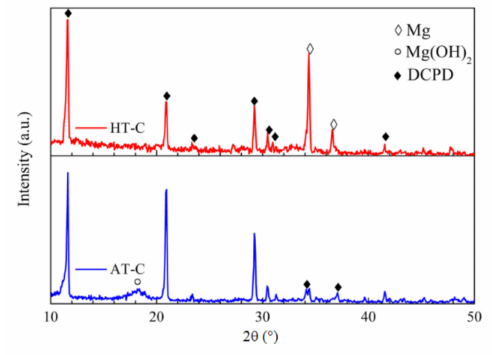
Figure 5. X-ray di ff raction patterns of HT and AT samples after 10 min of CaPh